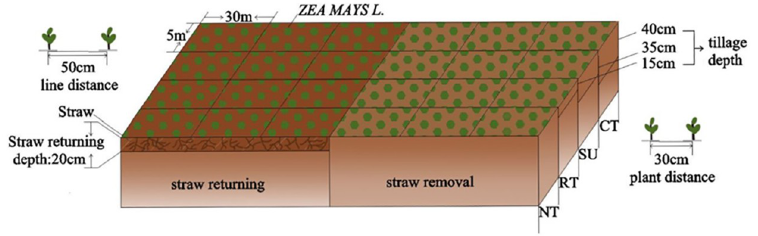
Fig 1. Detailed description of different tillage